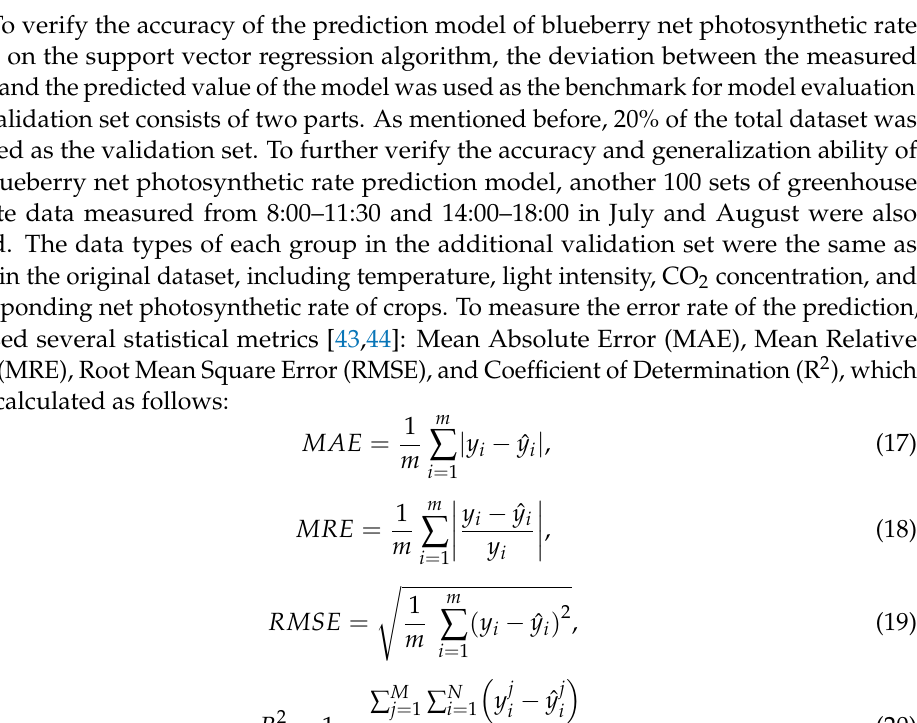
Figure 5. Change of photosynthetic rate values under photon flux density and CO 2 concentration.